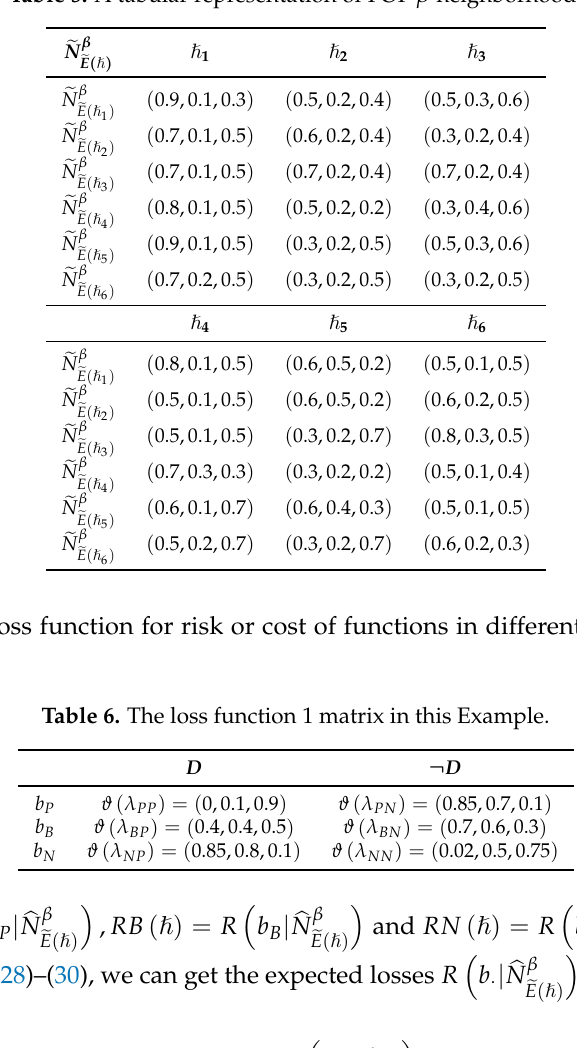
Table 7. Expected losses R